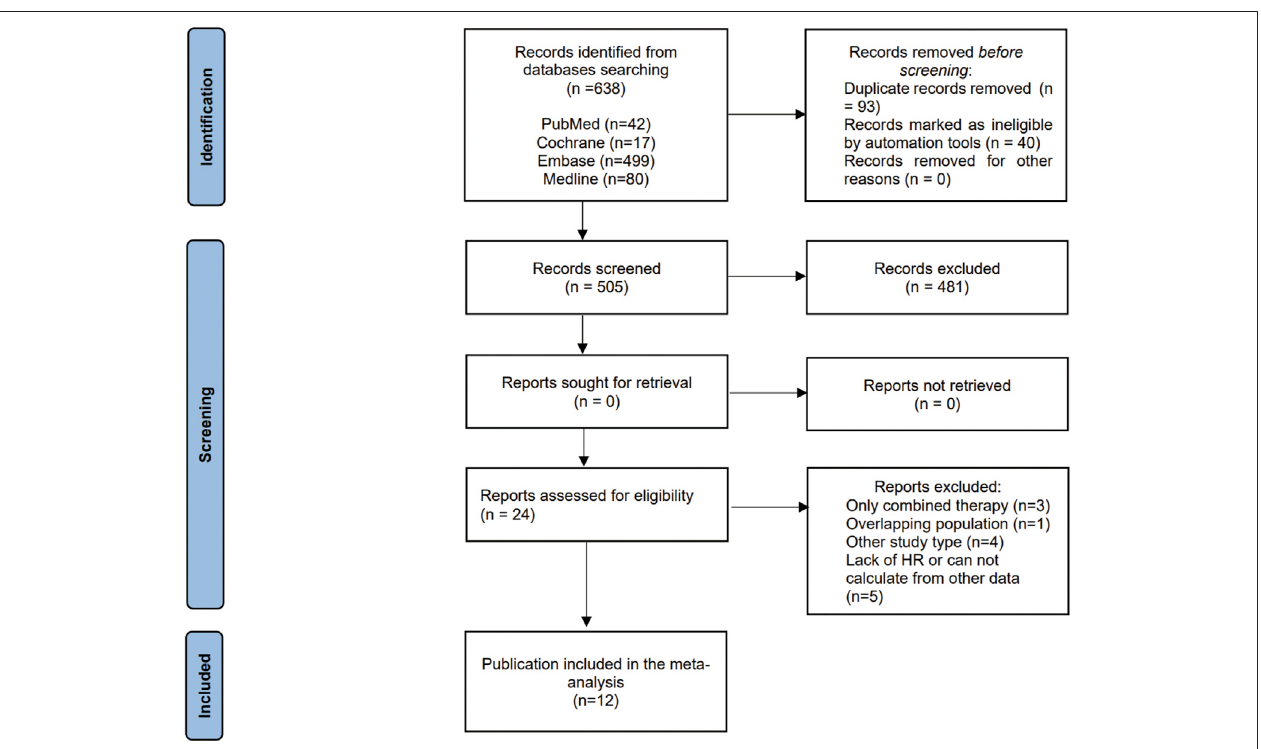
FIGURE 1 | Flow chart of studies selection. HR = hazard